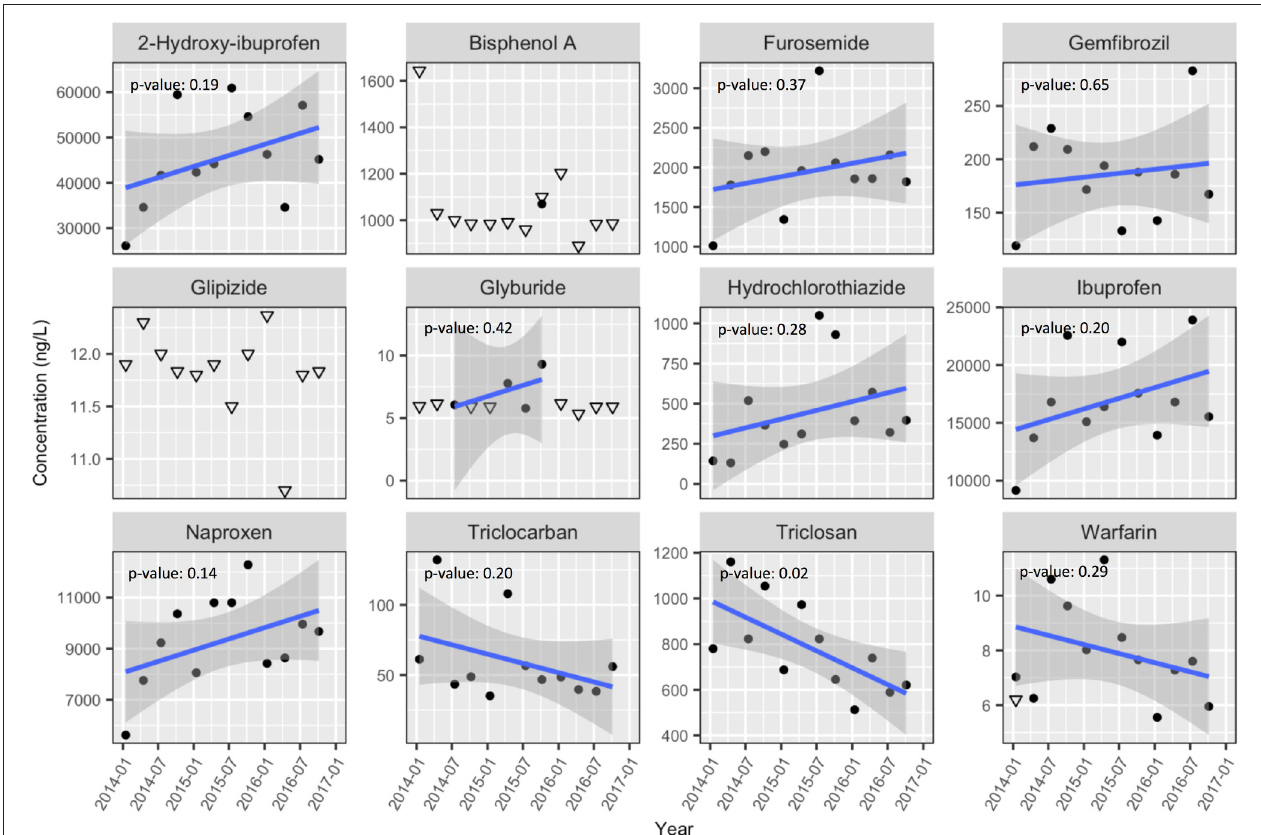
FIGURE 3 | Same as Figure 2 but for CLO wastewater. Again, downward facing open triangles indicate the sample specific detection limit where no detection occurred. Post-2014 data are presented separately from 2009 data due to changes in analytical methods.